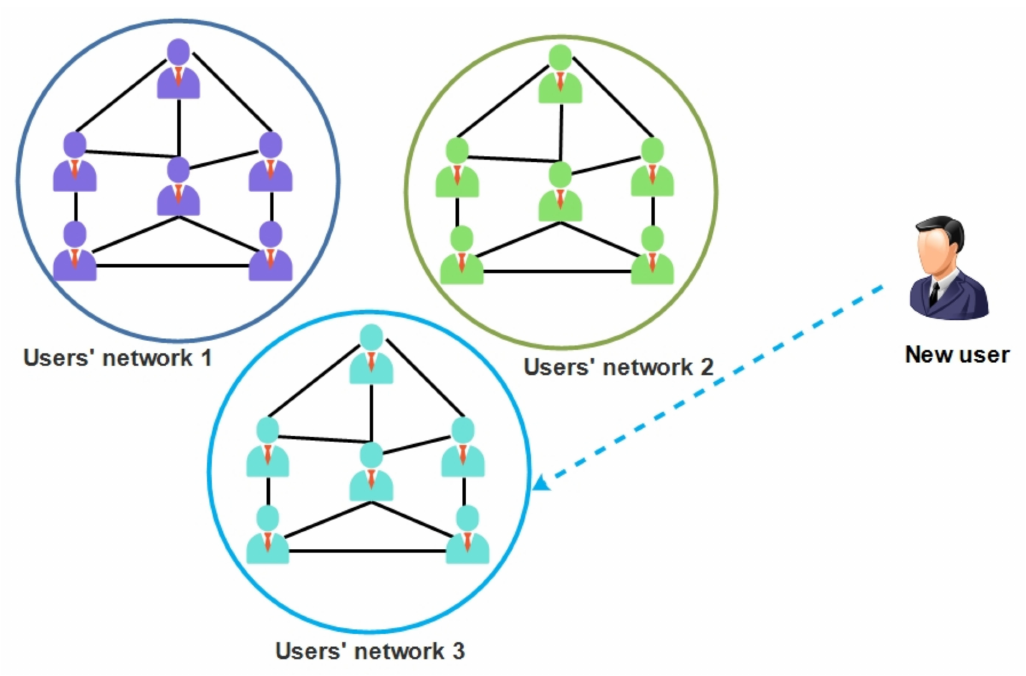
Figure 4. Similar users are clustered into sub-groups so that a cold start user could be allocated and inferred to a sub-group having similar profiles for